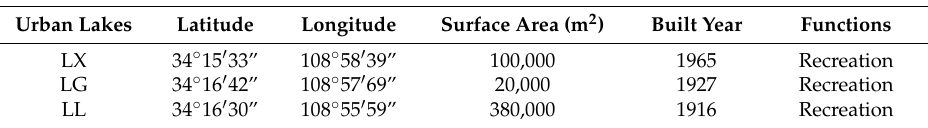
Table 1. The geographical location of Xingqing lake (LX), Geming lake (LG) and Lianhu lake (LL) in Xi’an City, Shaanxi Province,